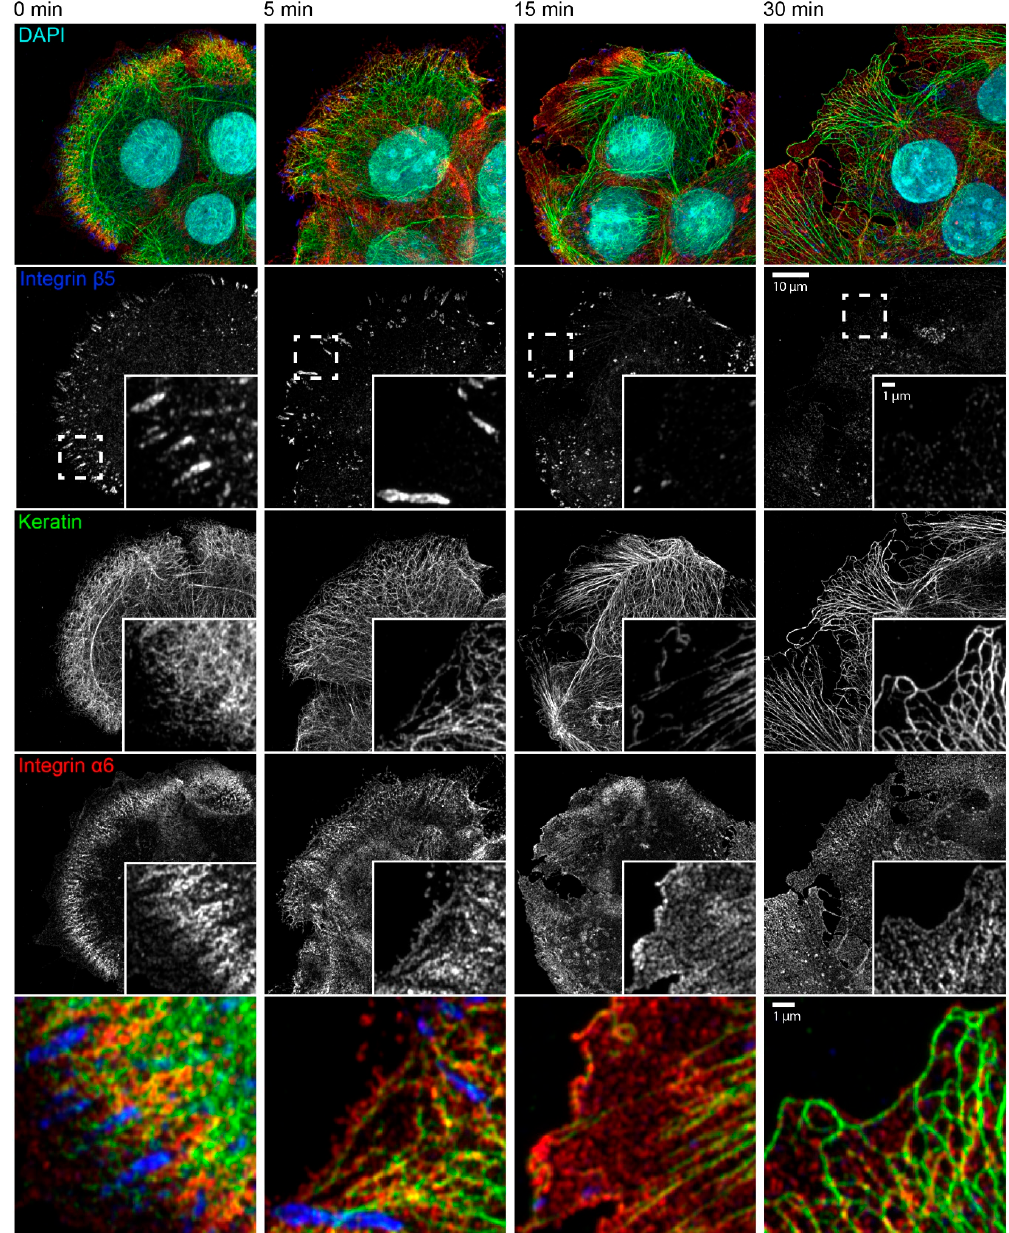
Figure 4. Keratin network reorganization after actin filament and microtubule disruption is not dependent on focal adhe- sions. The microscopic fluorescence images show the immunodetection of integrin β 5, keratin, and integrin α 6, together with nuclear DAPI staining, in methanol-fixed HaCaT keratinocytes that were treated with 3 µM latrunculin B and 20 µM nocodazole for different time periods. The inserts present the boxed regions (broken lines) at higher magnification. The bottom panel depicts merged images of the boxed regions. Before treatment, keratin filament bundles are attached to integrin α 6-positive hemidesmosomal structures that are next to integrin β 5-positive focal adhesions. Focal adhesions disassemble leading to granular integrin β 5 clusters after 15 min and barely detectable clustered integrin β 5 after 30 min of inhibitor treatment. At the same time, keratin filaments bundle, straighten, and retract toward the cell interior, while remaining attached to integrin α 6-positive hemidesmosomes. Note that short keratin filaments elongate in the cell periph- ery, which become more prominent with time and co-localize with integrin α 6 particles. All images are maximum intensity projections of entire cells ( n ≥ 7).